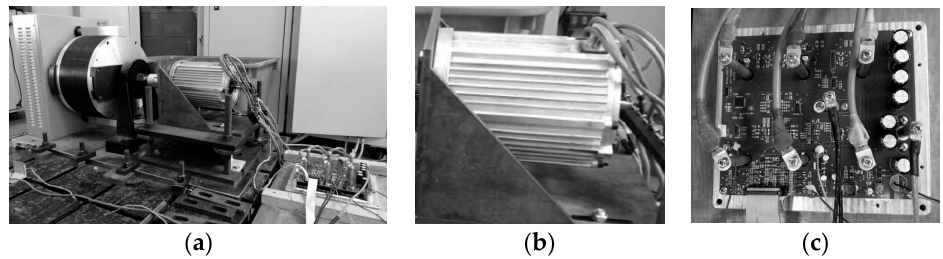
Figure 6. Control system of reluctance switch prototype. ( a ) Power test of SRM. ( b ) Tested motor. ( c ) Motor controller.